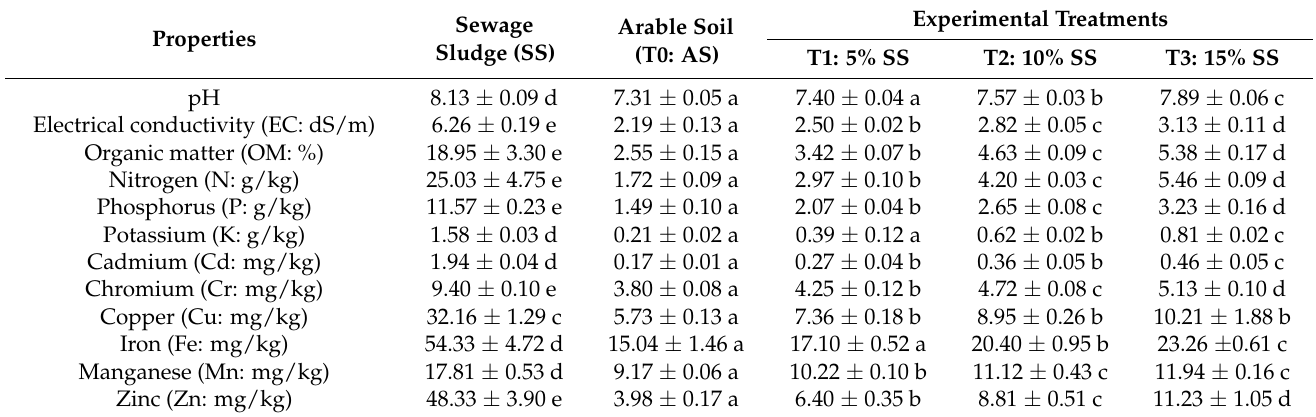
Table 1. Properties of the experimental arable soil and sewage sludge used for the dhaincha ( S. bispinosa ) cultivation